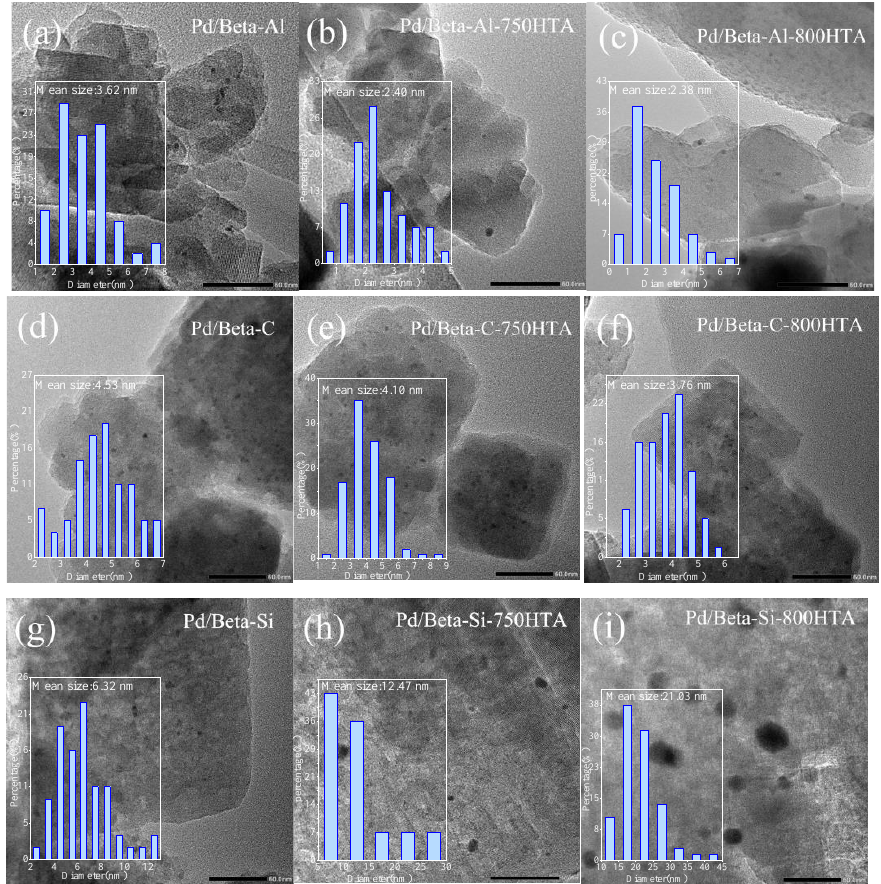
Figure 5. TEM images of ( a ) Pd/Beta-Al, ( b ) Pd/Beta-Al-750HTA, ( c ) Pd/Beta-Al-800 HTA, ( d ) Pd/Beta-C, ( e ) Pd/Beta-C-750HTA, ( f ) Pd/Beta-C-800 HTA, ( g ) Pd/Beta-Si, ( h ) Pd/Beta-Si-750HTA and ( i ) Pd/Beta-Si-800 HTA.